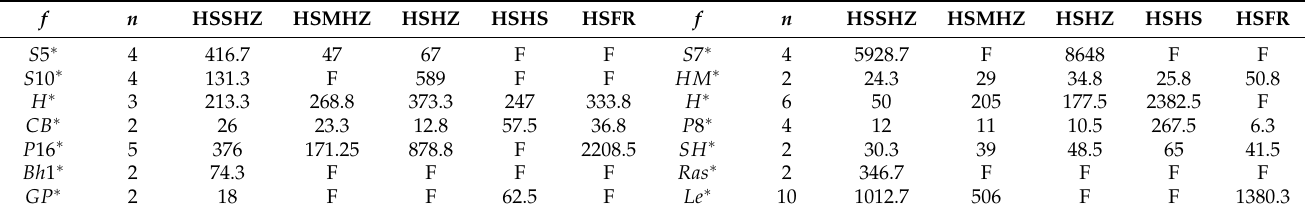
Table 14. The average of number of iterations.